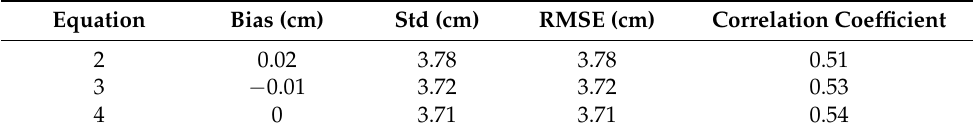
Table 5. Statistics of the calibration results on FYI.